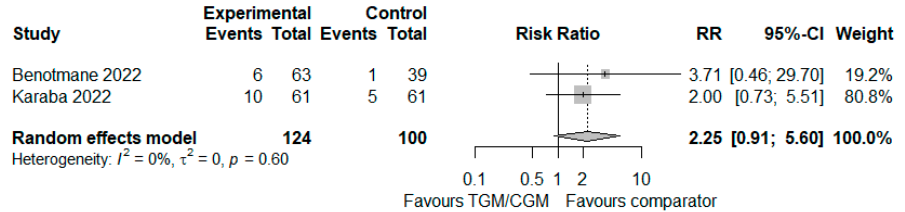
Figure 9. Rate of neutralization of COVID-19 Omicron variant (TGM/CGM vs. comparator). CI, con- fidence interval; RR, risk ratio; TGM/CGM, tixagevimab/cilgavimab.